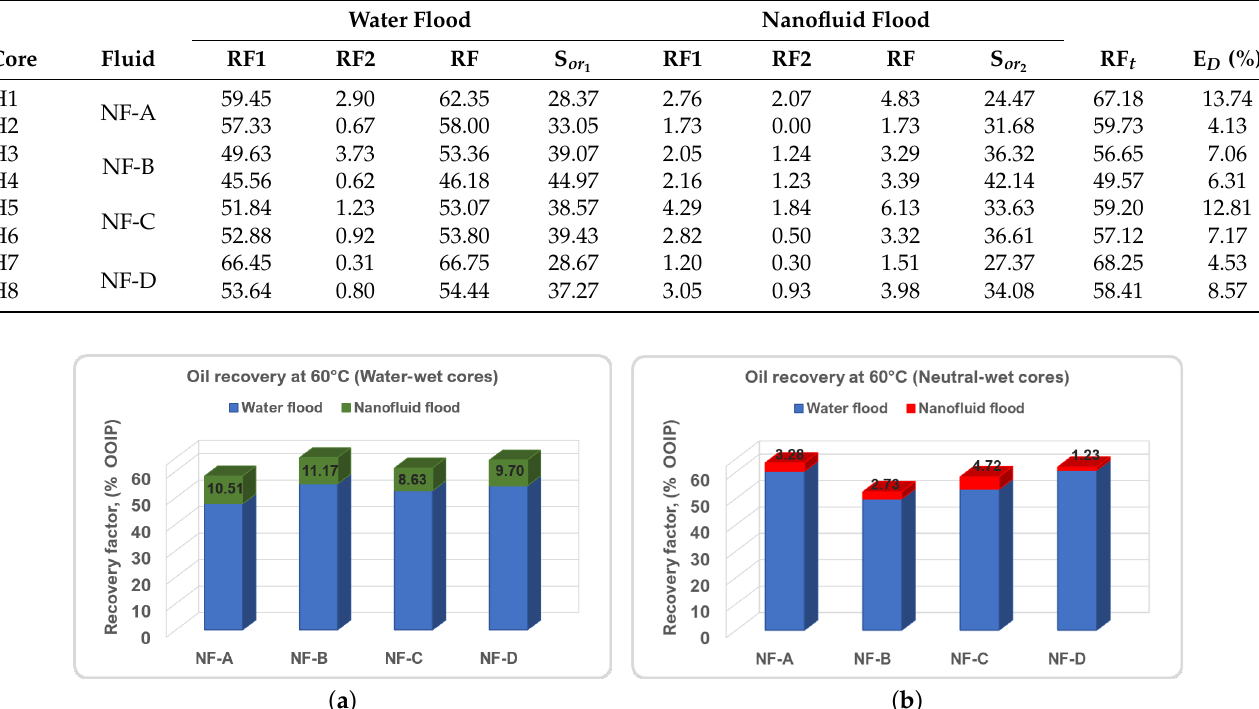
Figure 5. Comparison of average oil recoveries from various nanofluid floods: ( a ) Water-wet cores [16], and ( b ) Neutral-wet Berea core (present